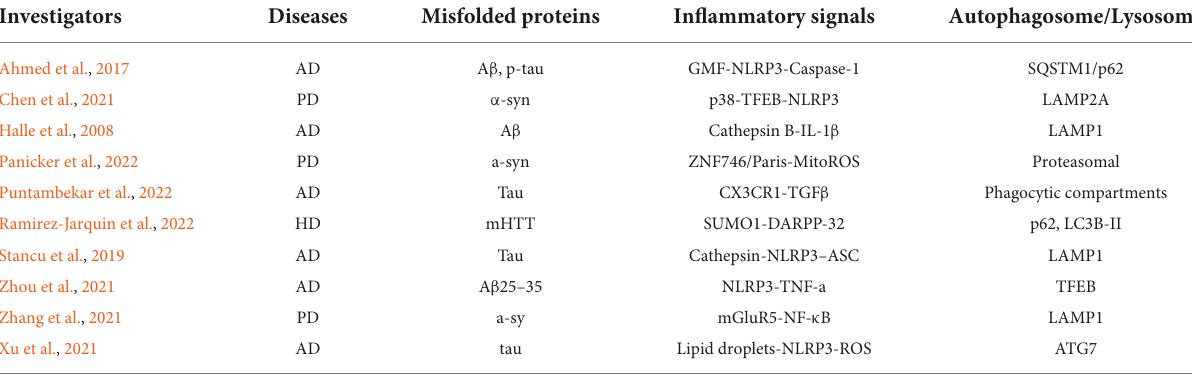
TABLE 1 Misfolded proteins, neuroinflammation, and autophagosome/lysosome interactions in neurodegenerative diseases.